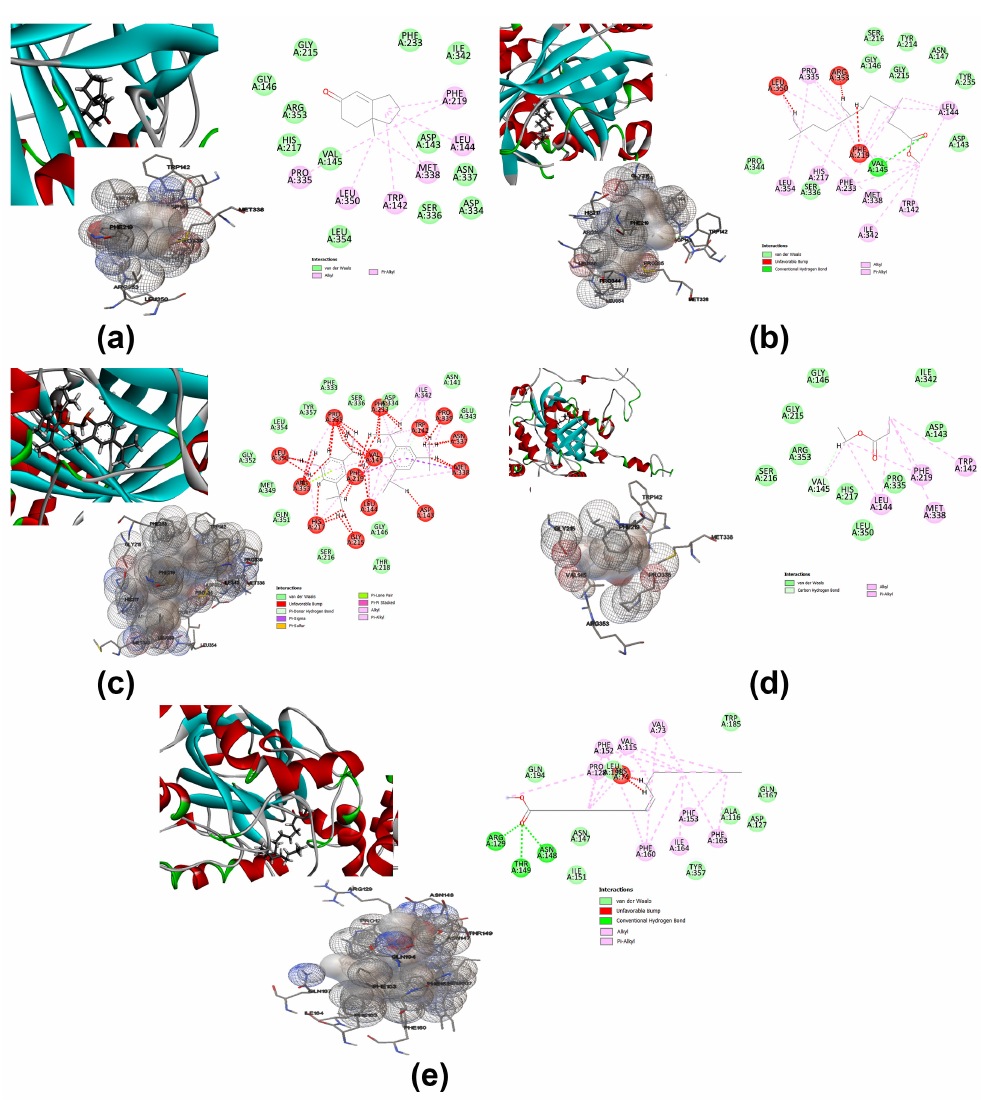
Figure 10. This is a figure. Schemes follow the same formatting. If there are multiple panels, they Figure 10. Several non-covalent interactions between the amino acids of 1AR5 and ( a ) MHI, ( b ) MTTP, should be listed as: ( a ) Description of what is contained in the first panel. ( b ) Description of what is ( c ) MTP, ( d ) PAE mand ( e ) contained in the second panel. Figures should be placed in the main text near to the first time they are cited. A caption on a single line should be centered.